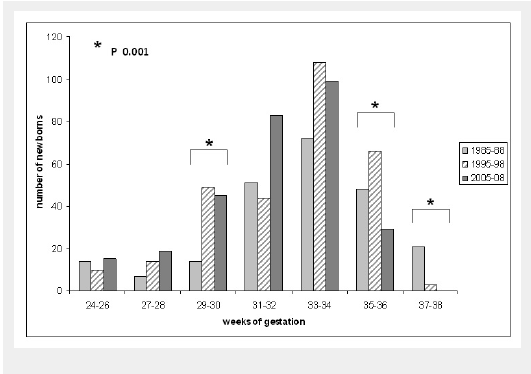
Distribution of live born triplets according to gestational age in the three Swiss surveys.